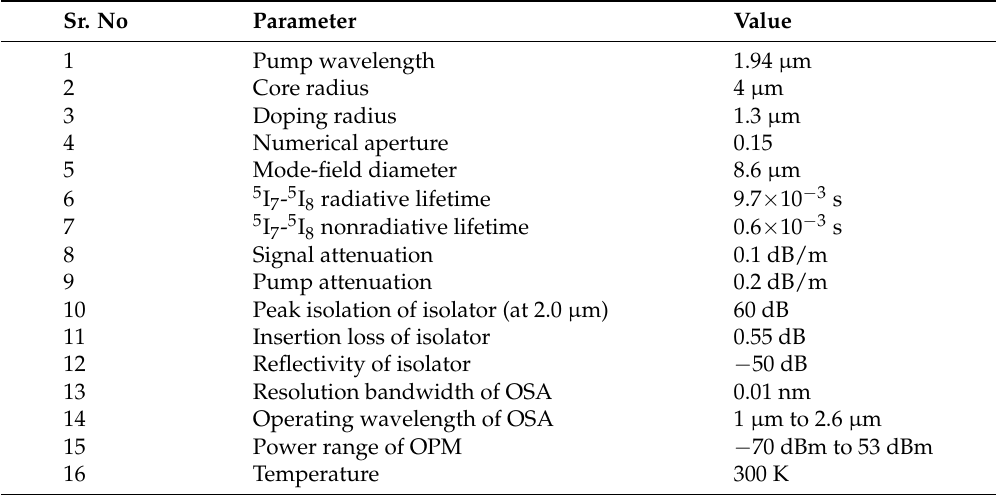
Table 2. Description of major simulation parameters used in our